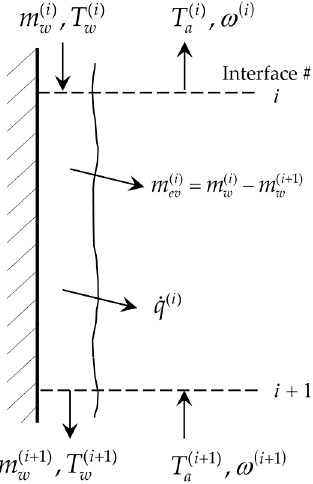
Figure 3. Heat and mass transfer phenomena at the interface between downward water film and upward air within a single control volume of the cooling tower’s fill section.